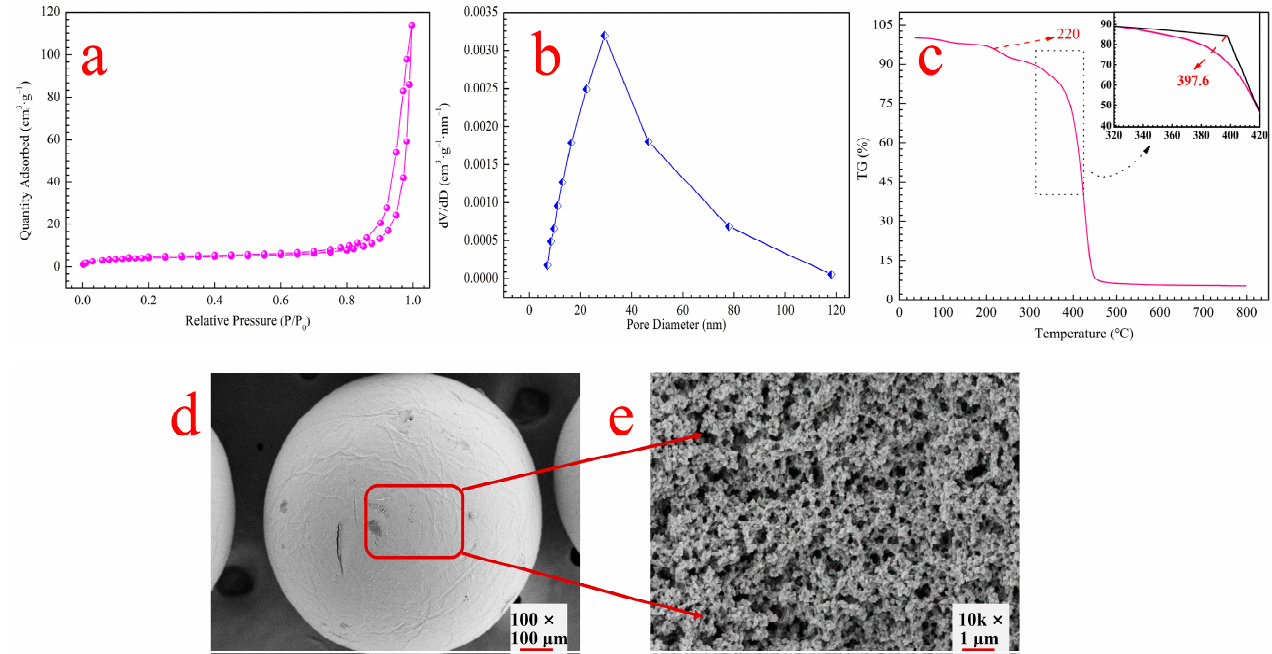
Figure 1. Characterization of the RMCRs by N 2 adsorption–desorption isotherms ( a ), pore size distributions ( b ), TGA ( c ), and SEM ( d , e ).